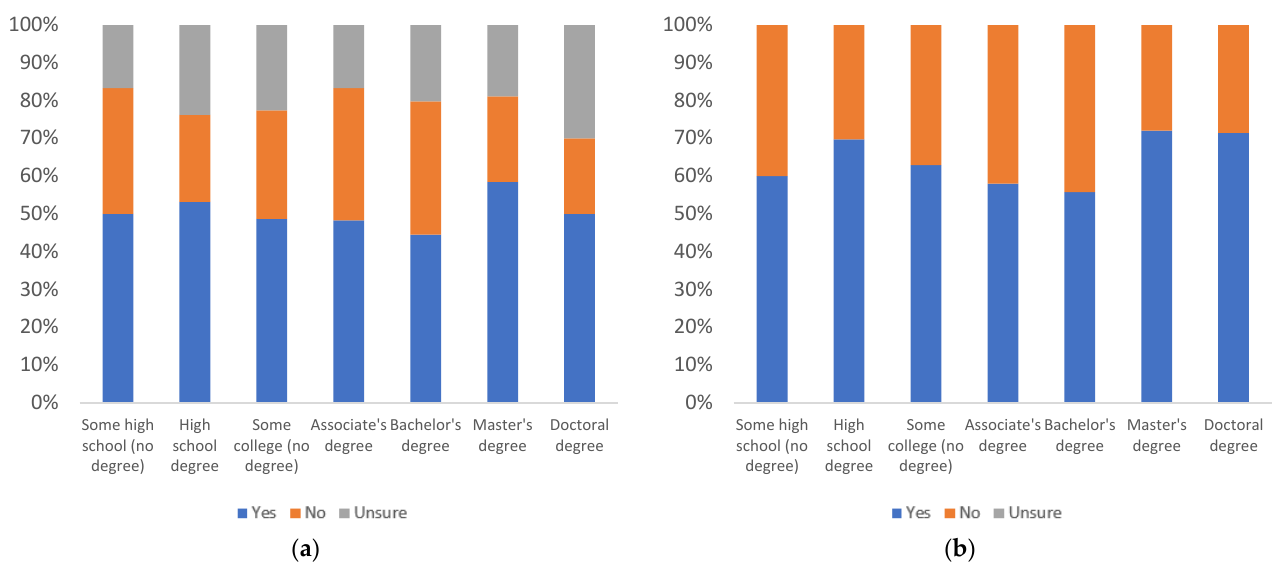
Figure 18. Label trustworthiness judging use, by education level: ( a ) with uncertain respondents (left) and ( b ) without uncertain respondents (right).